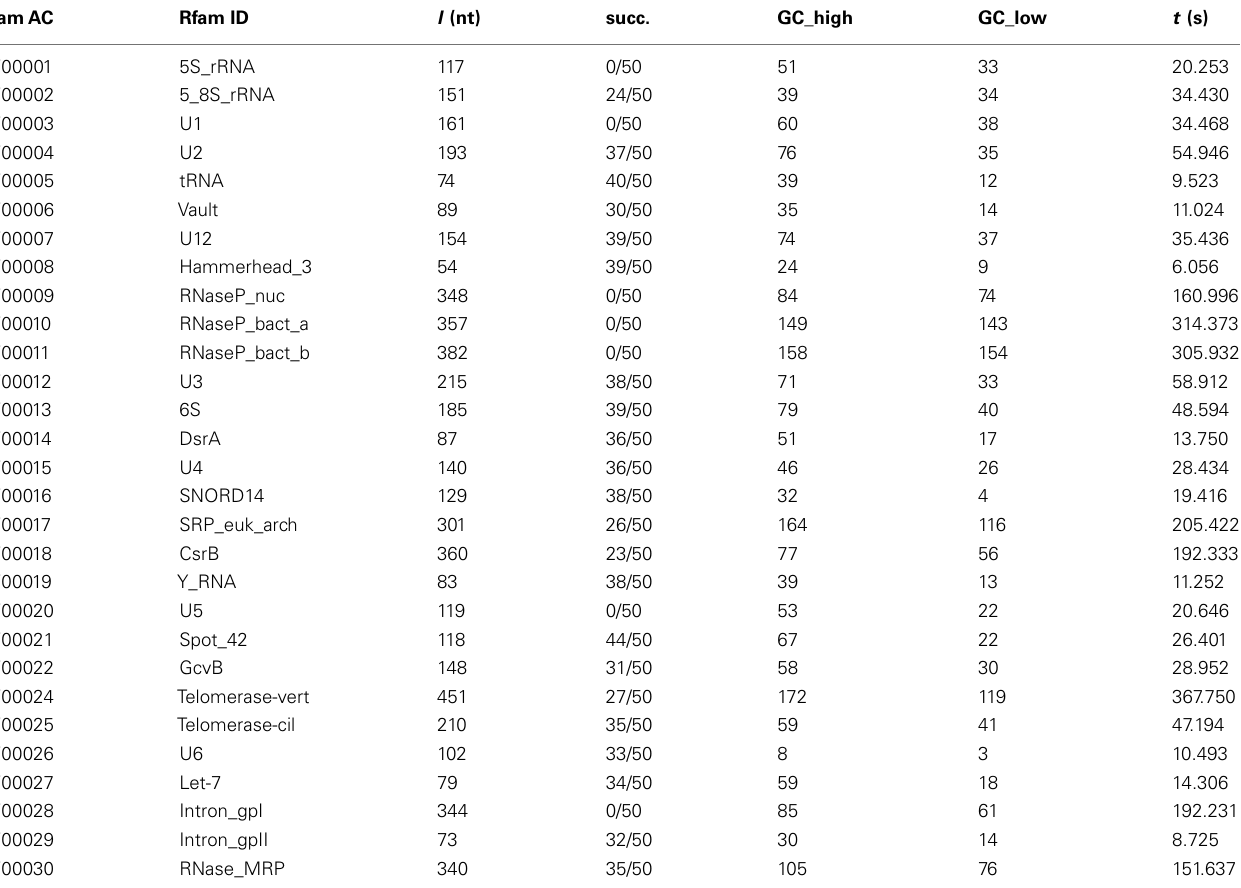
Table 1 |The benchmark results for the pseudoknot-free Rfam